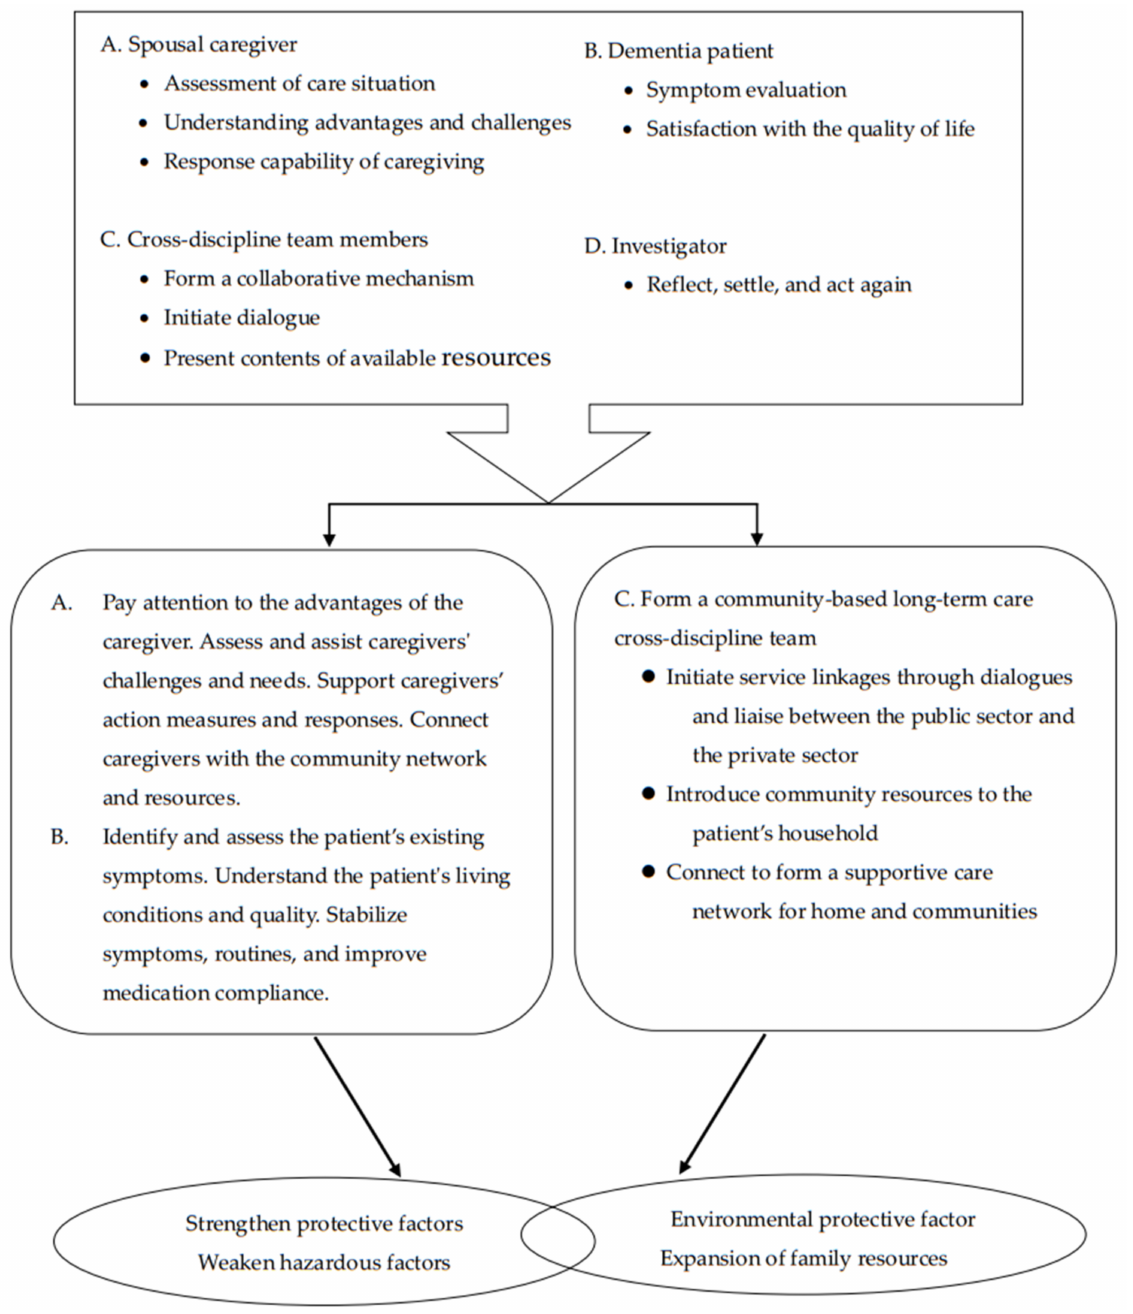
Figure 2. The action of home care empowerment